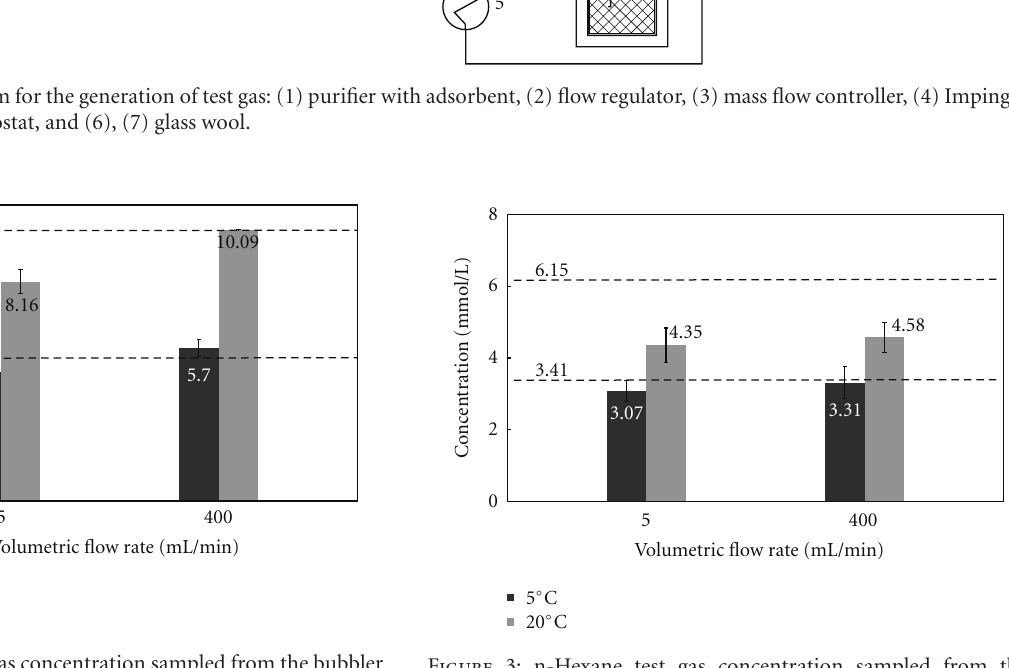
Figure 3: n-Hexane test gas concentration sampled from the bubbler system system calculated concentrations from Table